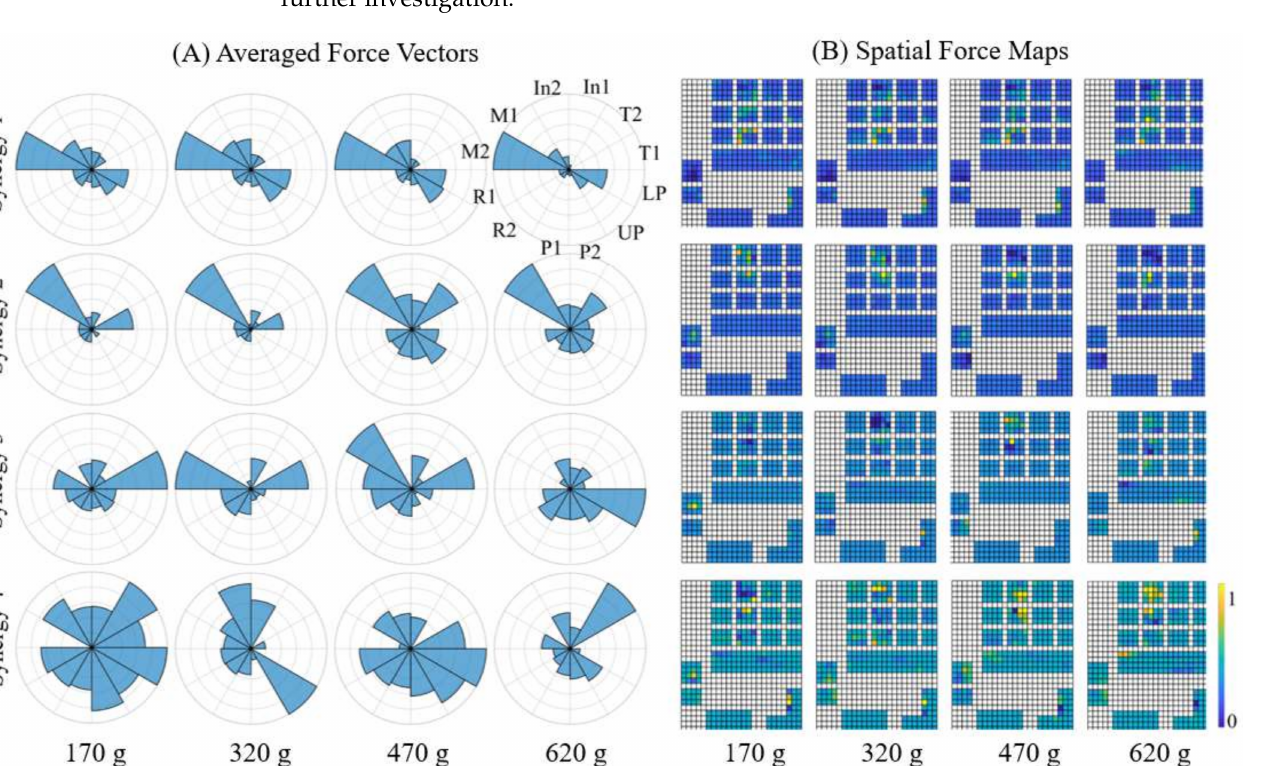
Figure 6. ( A ) Dynamical synergies extracted from averaged force vectors of Subject 8. The first and second synergies share the common load force zones regardless of the object weight. The middle digits (M1 and M2) carried the most dominant force characteristics; thumb and palm also contributed to sharing the force strategies. High correlations were observed among four weights. ( B ) Dynamical synergies extracted from spatial force maps of Subject 8. The first two synergies share the common load force zones and there is variability across synergies. The color bar indicates the normalized scale of forces obtained from principal